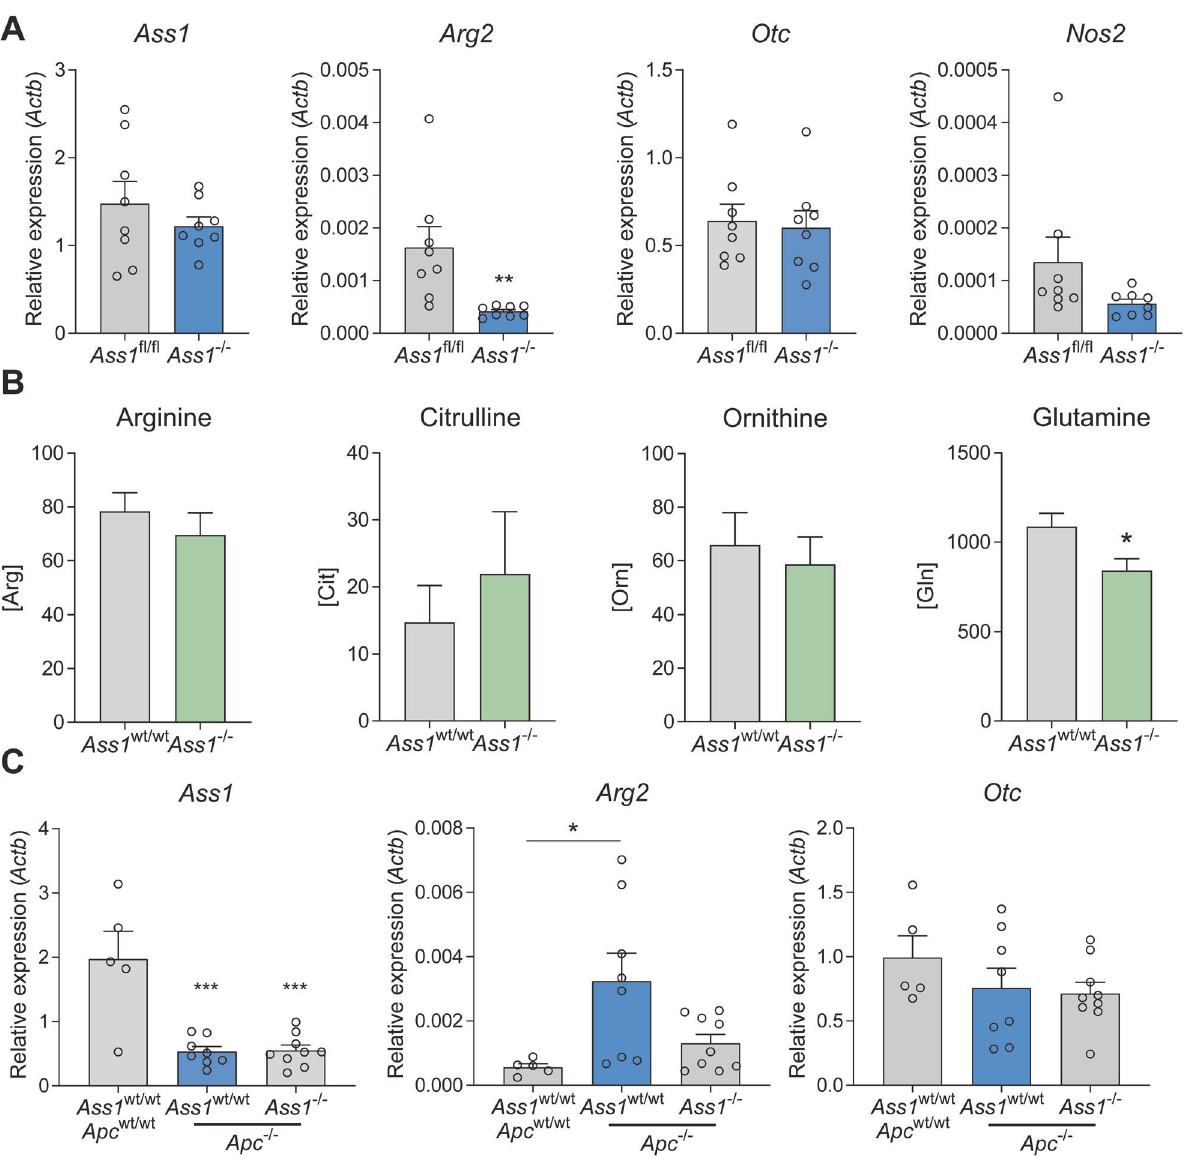
Fig. 8 Plasma glutamine levels and expression of urea-cycle enzymes in the liver, might compensate for intestinal loss of Ass1 . A qRT- PCRs for indicated genes in liver tissue from VillinCre ERT2 Ass1 wt/wt and VillinCre ERT2 Ass1 − / − mice 96 h after 14 Gy irradiation. Actb was used as a reference gene. ** p < 0.01 by Student ’ s t -test. B Plasma levels of indicated amino acids measured by HPLC from VillinCre ERT2 Ass1 wt/wt and VillinCre ERT2 Ass1 − / − mice 96 h after 14 Gy irradiation. * p < 0.05 by Student ’ s t -test. C qRT-PCRs for indicated genes in liver tissue from VillinCre ERT2 Ass1 wt/wt Apc wt/wt , VillinCre ERT2 Ass1 wt/wt Apc − / − , and VillinCre ERT2 Ass1 − / − Apc − / − mice, 5 days after induction. Actb was used as a reference gene. * p < 0.05 by one-way ANOVA with Tukey ’ s multiple comparisons